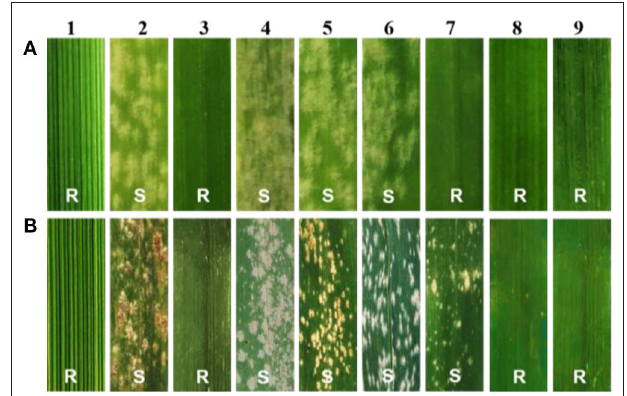
FIGURE 1 | Evaluation of powdery mildew resistance. (A) The seedling stage. (B) The adult stage. 1–9 refer to Th. ponticum , HXH, SNTE20, SNF63, YN15, SN224, JM22, SN0293-2, and SN0293-7,